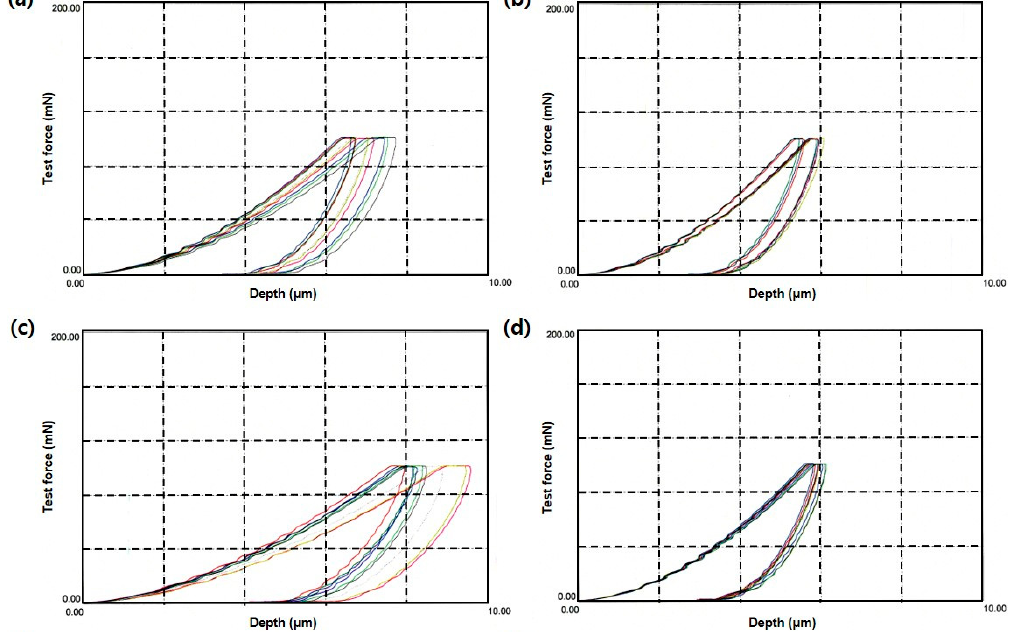
Figure 3. Cont. Figure 3.